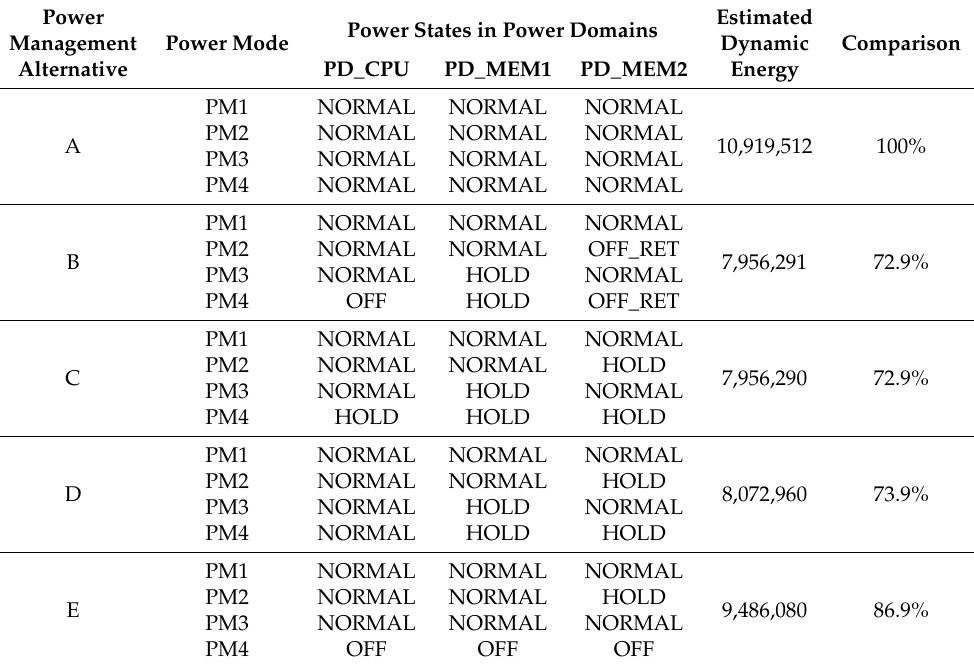
Table 1. Illustration of the power-management